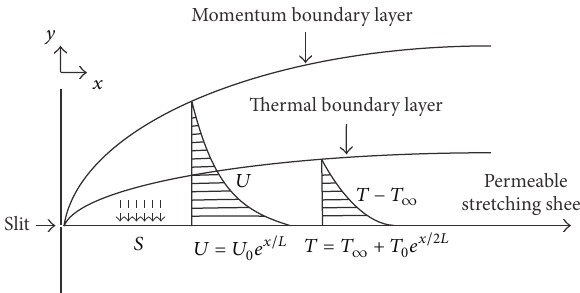
Figure 1: Schematic representation of boundary layer